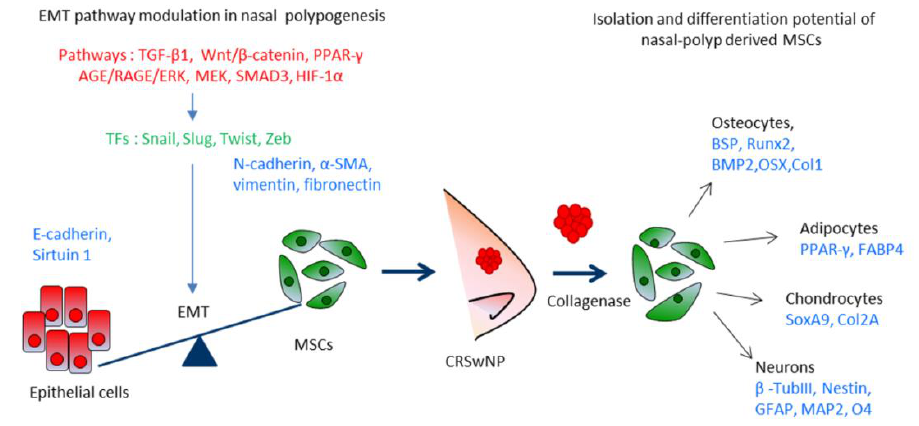
Figure 1. From nasal polyp biogenesis with EMT to MSCs isolation. Epithelial cells from the mucosa of the CRSsNP express specifically high levels of E-cadherin and can undergo EMT in response to a series of factors / pathways (TGF- β 1, AGE / RAGE / ERK / MEK, SMAD / HIF-1 α , Wnt / β -catenin, and PPAR γ ), which induce transcription factors (TFs) typically required for EMT remodeling (Snail, Slug, Twist, and Zeb). This process results in the formation of mesenchymal cells as an important component of the nasal polyps (CRSwNP). Biopsies of polyps can be disaggregated and MSCs selected, cultivated in vitro, and induced to di ff erentiate into osteocytes, adipocytes, chondrocytes, and neuron-like cells, where characteristic proteins are detected.